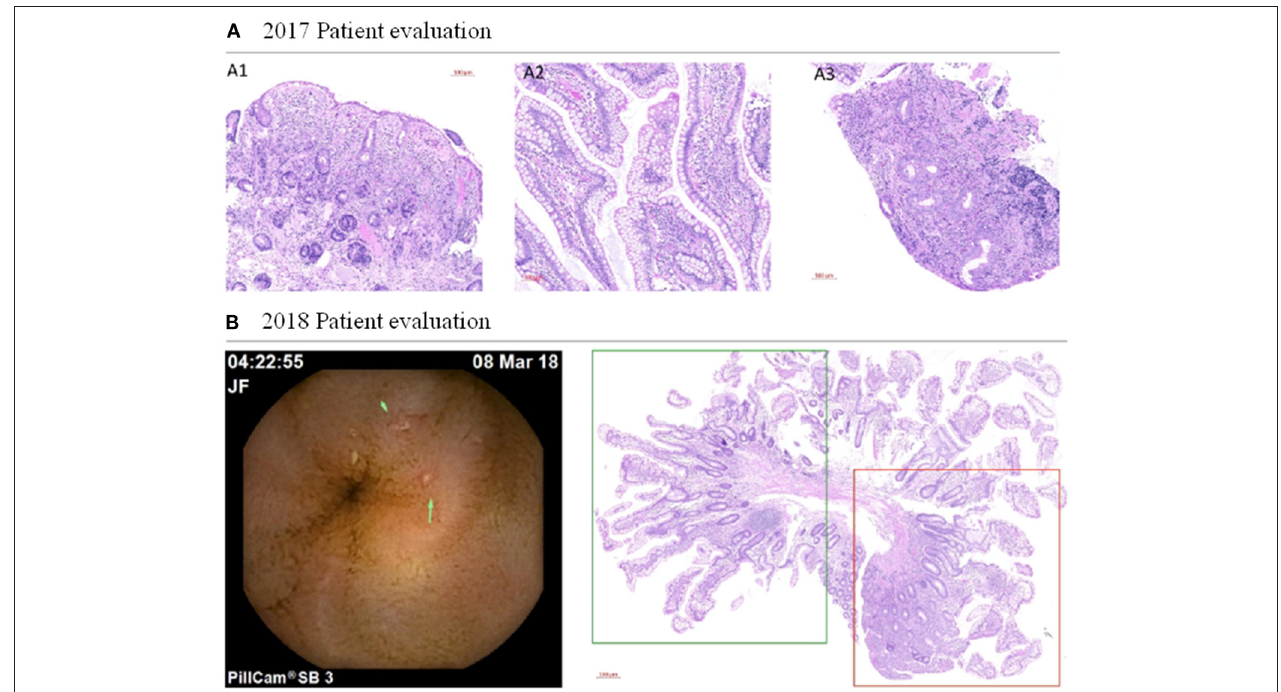
FIGURE 2 | Clinicopathologic evaluation of the patient. (A) Histopathologic evaluation of the patient’s 2017 biopsy. Intestine biopsy revealed atrophic and flattened microvilli with reduction of goblet cells (A1), microvilli oedema and cryptitis (A2), and inflammatory infiltrate (A3). Scale bar: 100 µ m. (B) Histopathologic evaluation of the patient’s 2018 biopsy. Left panel: The endoscopy uncovered aphthous ulcers (green arrows) in the small intestine even without cytomegalovirus infection. Right panel: haematoxylin and eosin staining of biopsied tissue shows moderate microvilli atrophy in the normal intestinal tissue of the patient (boxed in green) and inflammation process (boxed in red). Scale bar: 500 µ